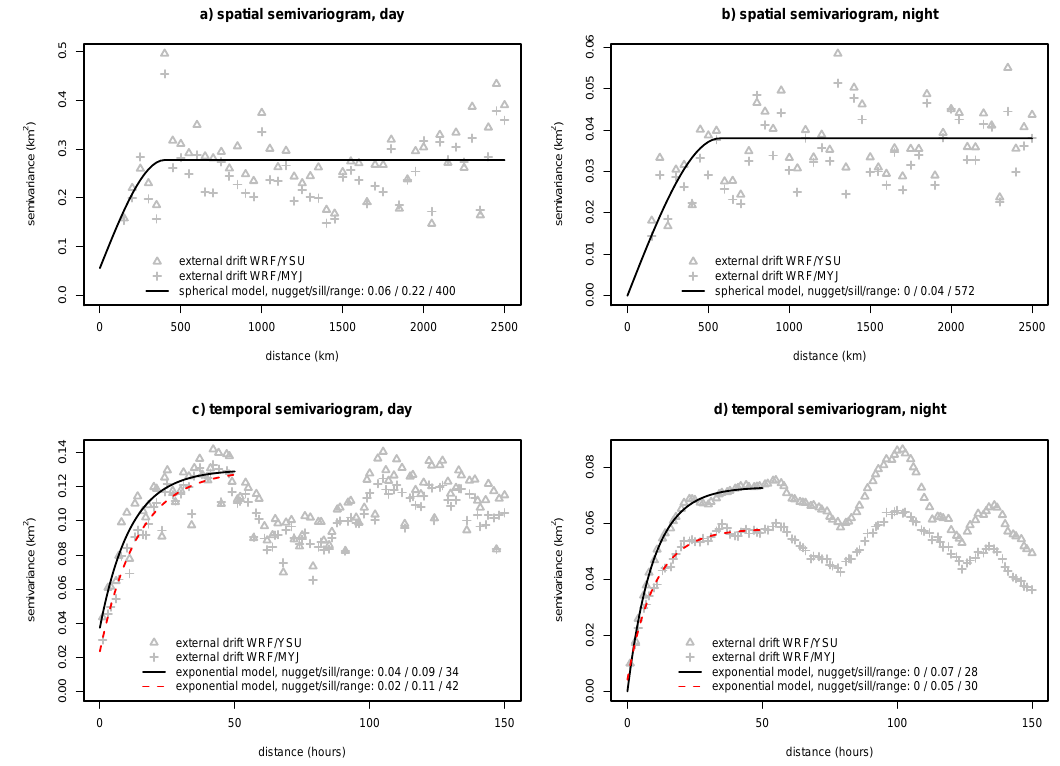
Figure 3. Spatial (a, b) and temporal (c, d) sample variograms as calculated with Eq. (7) for day and night separately. Spatial sample variograms were calculated from model/observation linear regression residuals for each WRF setup using MYJ (grey pluses) and YSU (grey triangles) PBL scheme. The time variograms were calculated from WRF MHs subtracting a diurnal trend (c, d) , notable differences between PBL setups were found; thus we fitted separate variogram models for each PBL scheme (c, d) . KED was set up to use 25 neighbours in space and 3 in time, i.e. 75 observations were used to predict each of the 141 . 12 × 10 6 grid cells of one WRF simulation. The maximal distance between any pair of observations were typically below 2500km in space and 48h in time because of the 12h temporal resolution of the conditioning data. The variogram models were fitted to cover these ranges. A temporal trend is observed at synoptic scales beyond 50h, which does not affect the fitted variogram models (c, d) . Table 1. Setup of WRF